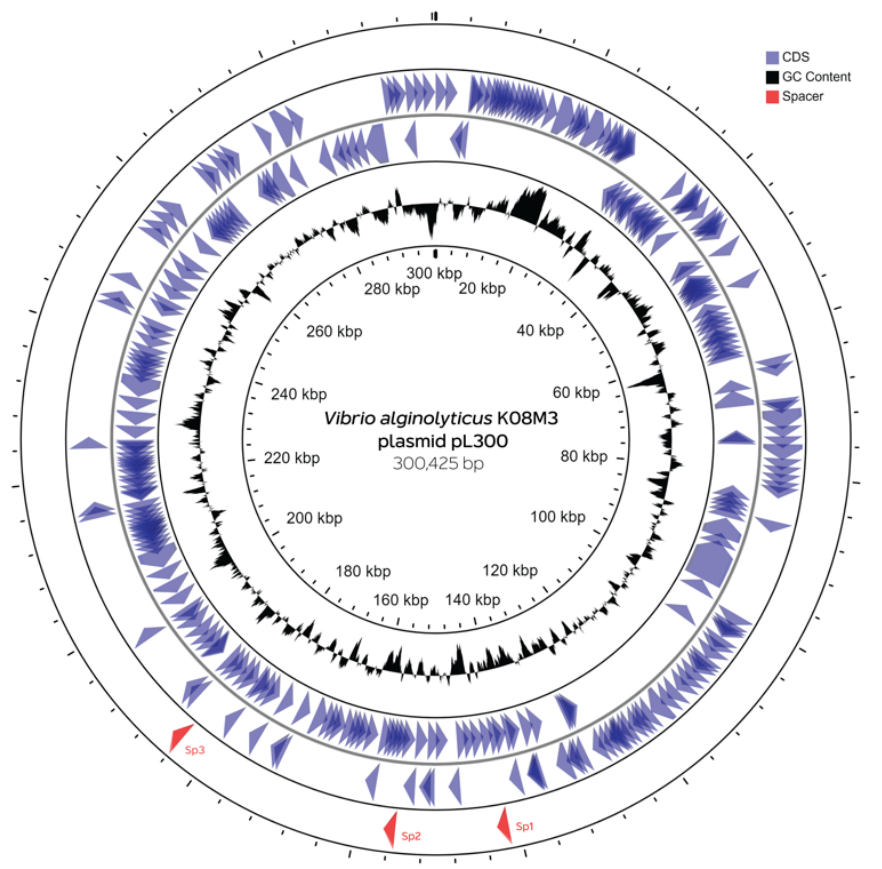
Figure 3. Distribution of protospacers along the representative plasmid pL300 of V. alginolyticus K08M3. The plasmid map is drawn from the GenBank entry CP017915.1 and ORFs are shown as arrows. Red arrows indicate the position of spacer-matching sequences (Sp1 to Sp3) found in the CRISPR region of V. parahaemolyticus analyzed in this study.